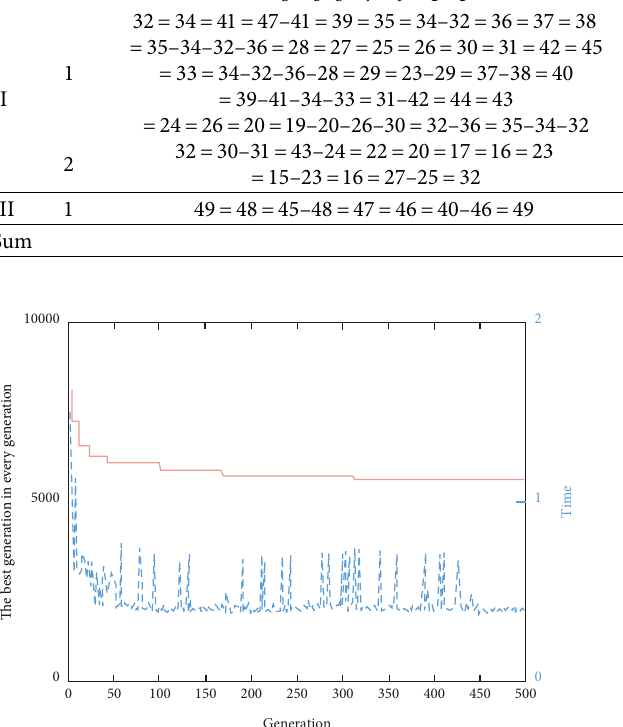
Figure 6: Evolution diagram of optimal solution and iteration time diagram of region 1.